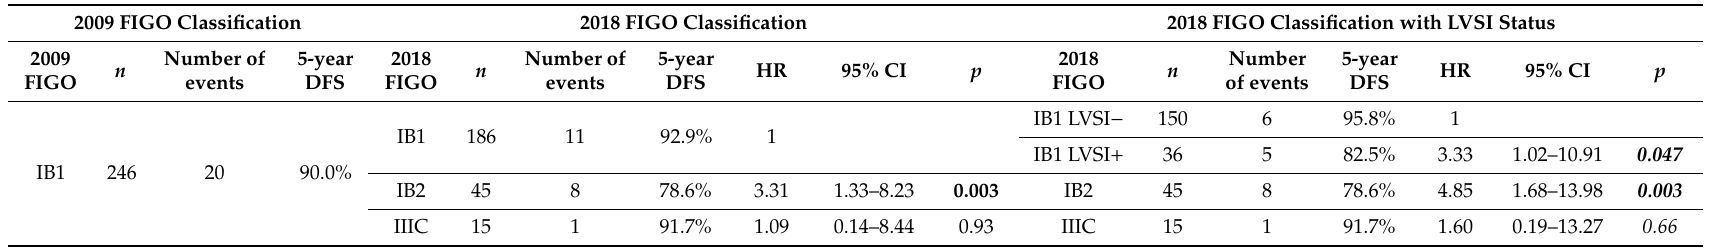
Table 3. Cox proportional Hazards models of 5-year Disease-free survival according to the 2009 FIGO and the revised 2018 FIGO staging systems.